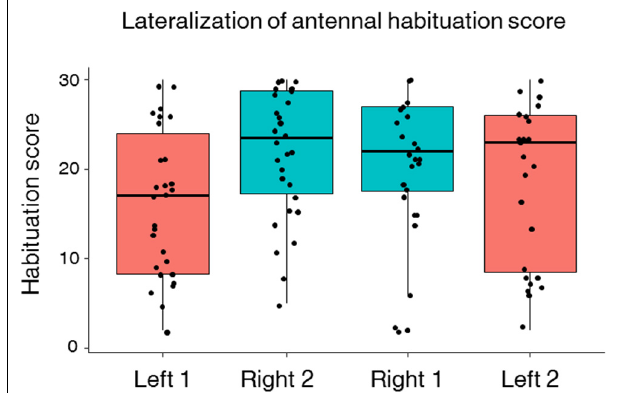
FIGURE 5 | Left–right antennal habituation score (HS). Median, quartiles, and max and min (upper and lower whiskers) sucrose response values of individual HSs for bees subjected to two phases of 30 consecutive antennal stimulations with 10% sucrose solution. Approximately half of the bees were tested for habituation first on the right antenna (Right 1) and then on the left antenna (Left 2) ( n = 27) and vice versa (Left 1 and Right 2) ( n = 30). Black dots represent individual bees. Bees with a score of 30 responded to all 30 sucrose stimulations, i.e., did not show any habituation. The right antenna had a higher score than the left antenna (LMM, p = 0.001) indicating a higher resistance to habituation on the right side compared to the left one. The order of testing had no significant effect on the